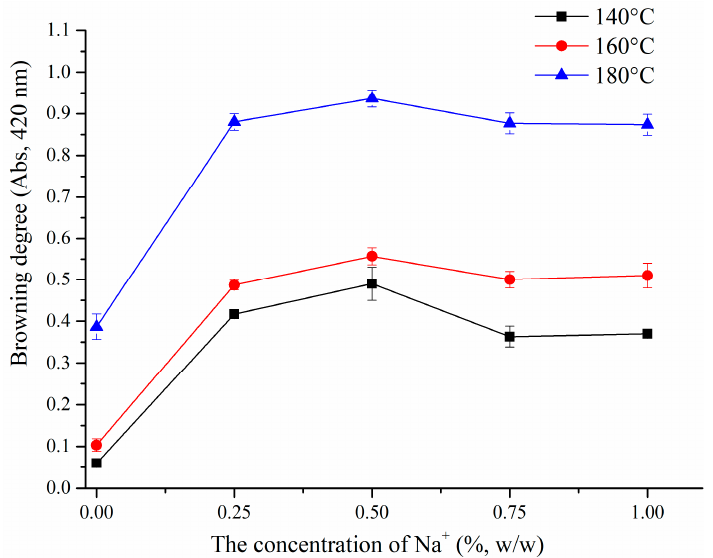
Figure 1. Browning intensity ( λ = 420 nm) at different sodium concentrations in model reaction systems.